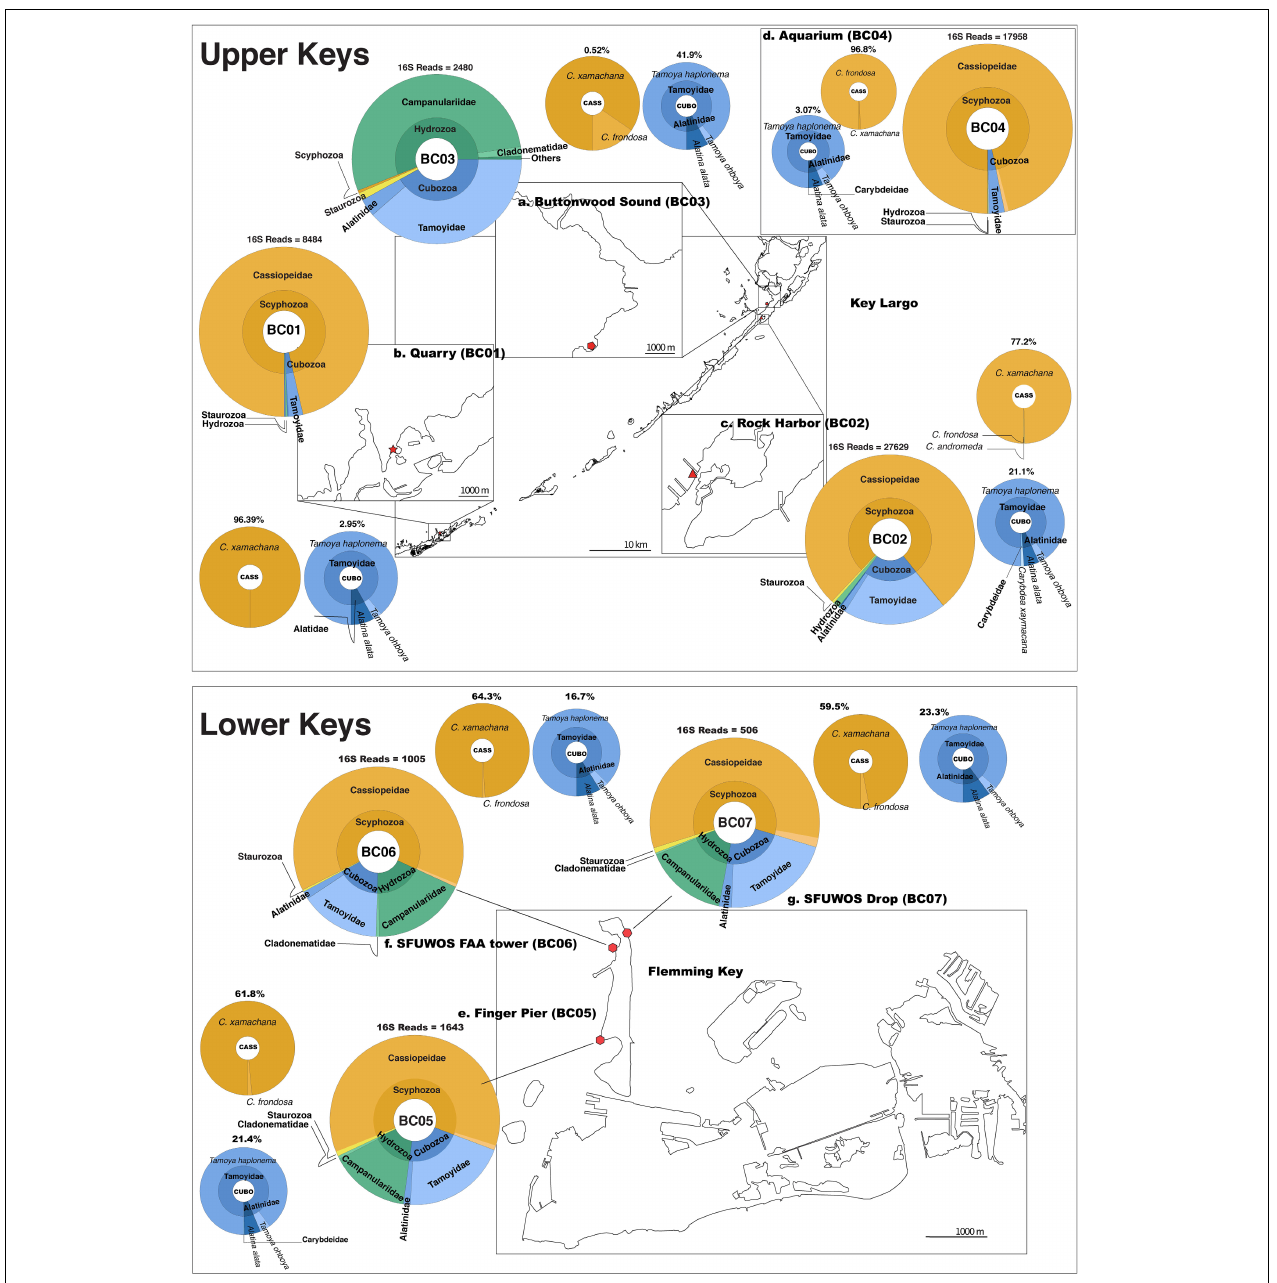
FIGURE 6 | Map depicting distribution of jellyfish species at Florida Keys sampling sites based on 16S rRNA gene. Upper Keys (Key Largo and Marathon Key), water samples (May 14–16, 2018). (a) Buttonwood Sound (BC03). 25.10143, –80.43861. (b) Quarry (BC01). 24.74975, –80.97812. (c) Rock Harbor (BC02). 25.07924, –80.45245. (d) Aquarium (BC04). 25.10135, –80.43861. Lower Keys (Fleming Key), water samples (May 17, 2018). (e) Finger Pier (BC05). 24.57581, –81.79922. (f) SFUWOS FAA Tower (BC06). 24.59015, –81.79704. (g) SFUWOS Drop (BC07). 24.59181, –81.79487; Negative control (BC08) not depicted. Red symbols correspond to sampling locations on the map. Large, multicolored pie charts show medusozoan diversity detected at each site and total number of 16S rRNA gene reads detected per location based on Qiime2 analysis. Percentages above smaller monochromatic pie charts highlight the percent of total reads corresponding to Cassiopea and cubozoan species, respectively. Results from the Qiime2 barplot function were modified and visualized here using Krona (Ondov et al., 2011). Percentages reflect proportions prior to rarefaction analysis (subsample normalization), which resulted in loss of three minimally represented